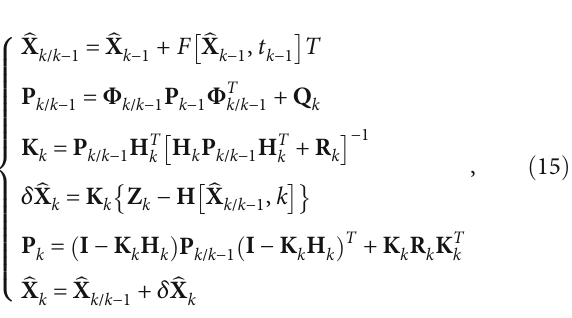
Figure 3: The structure of